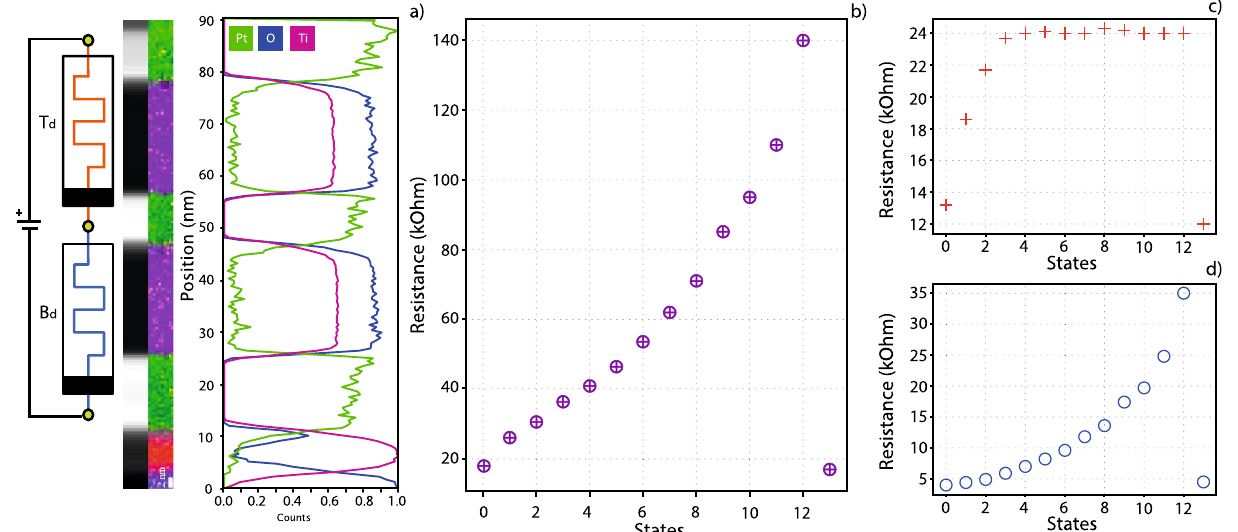
Figure 4. Simultaneous switching of memristors with the same switching polarity. Applied voltage is expected to have the same result on both devices, i.e., simultaneous resistive increase or decrease in both devices. ( a ) Schematic and an EELS image of the stack can be seen. ( b ) Complete device state evolution, where resistive change in states 1–4 is mainly driven by the Top device while resistive change in states 5–12 is driven mostly by the Bottom device. ( c , d ) State evolutions for both devices, common x-axis. After the 4th state change, the Top device saturates but the Bottom device keeps increasing its